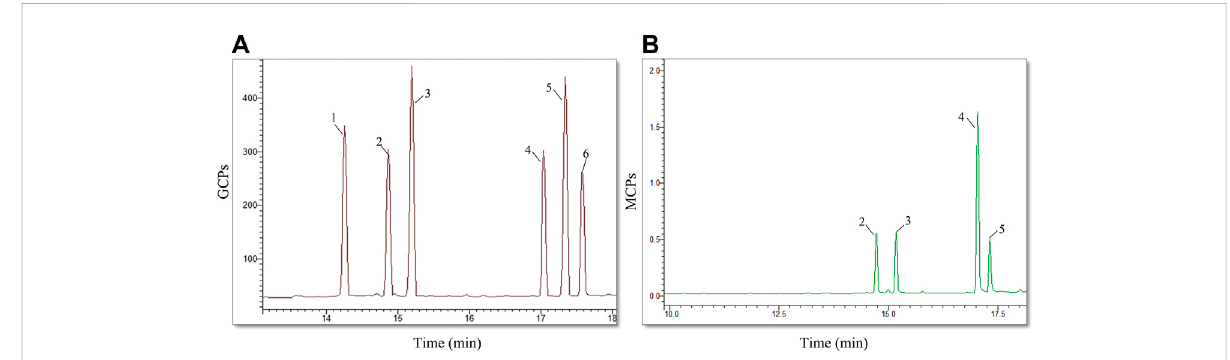
FIGURE 1 The monosaccharide composition analysis. (A) The chromatogram of mixed monosaccharide standards, showing a composition of rhamnose